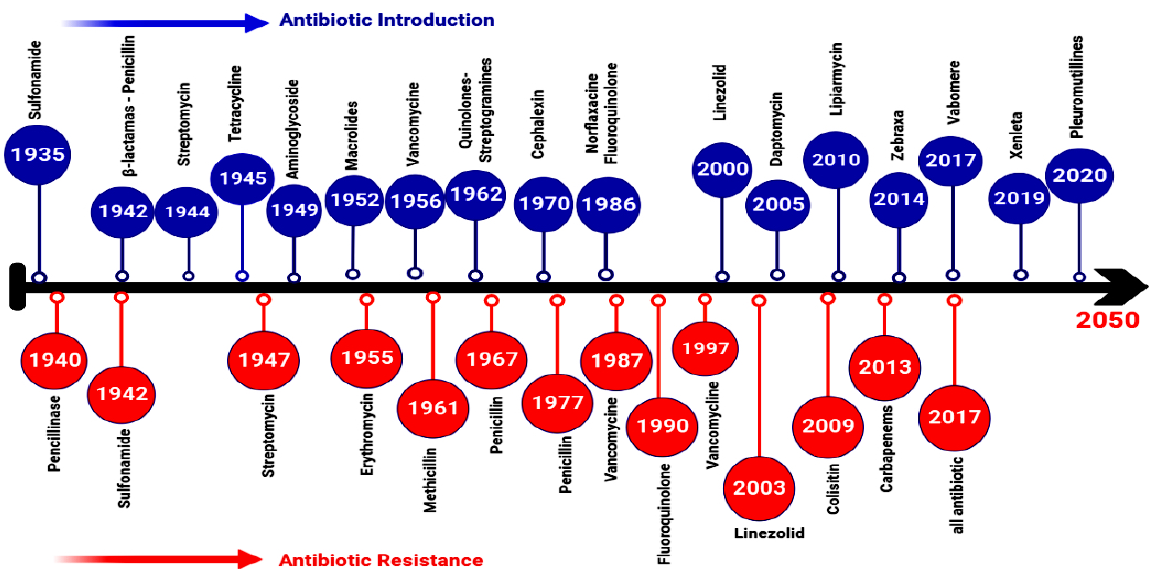
Figure 1. Timeline illustrates antibiotics